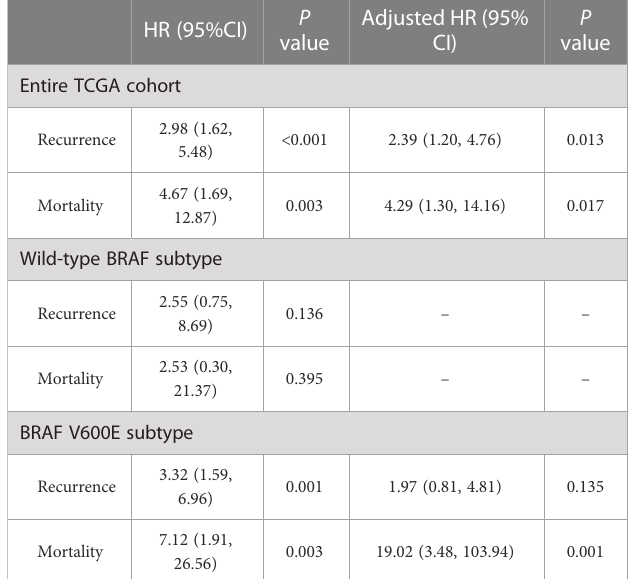
(Figure 6F). Taken together, STRA6 may promote TC metastasis via CAF-mediated EMT process.